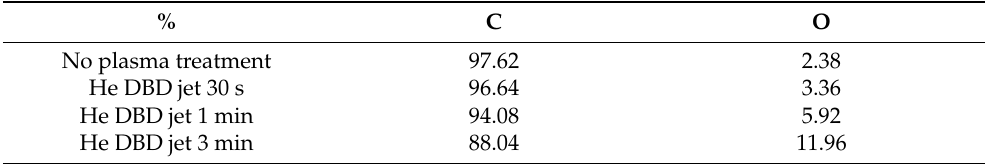
Table 1. Elemental composition of C and O in graphite foil, as determined from XPS spectra.